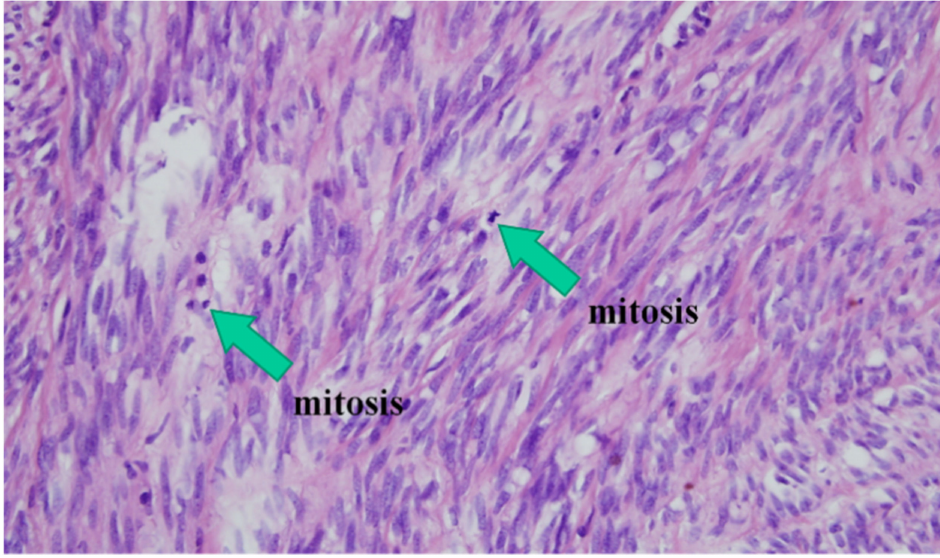
Figure 2. Mitosis in pathological findings. hematoxylin and eosin, original magnification, 400 × .